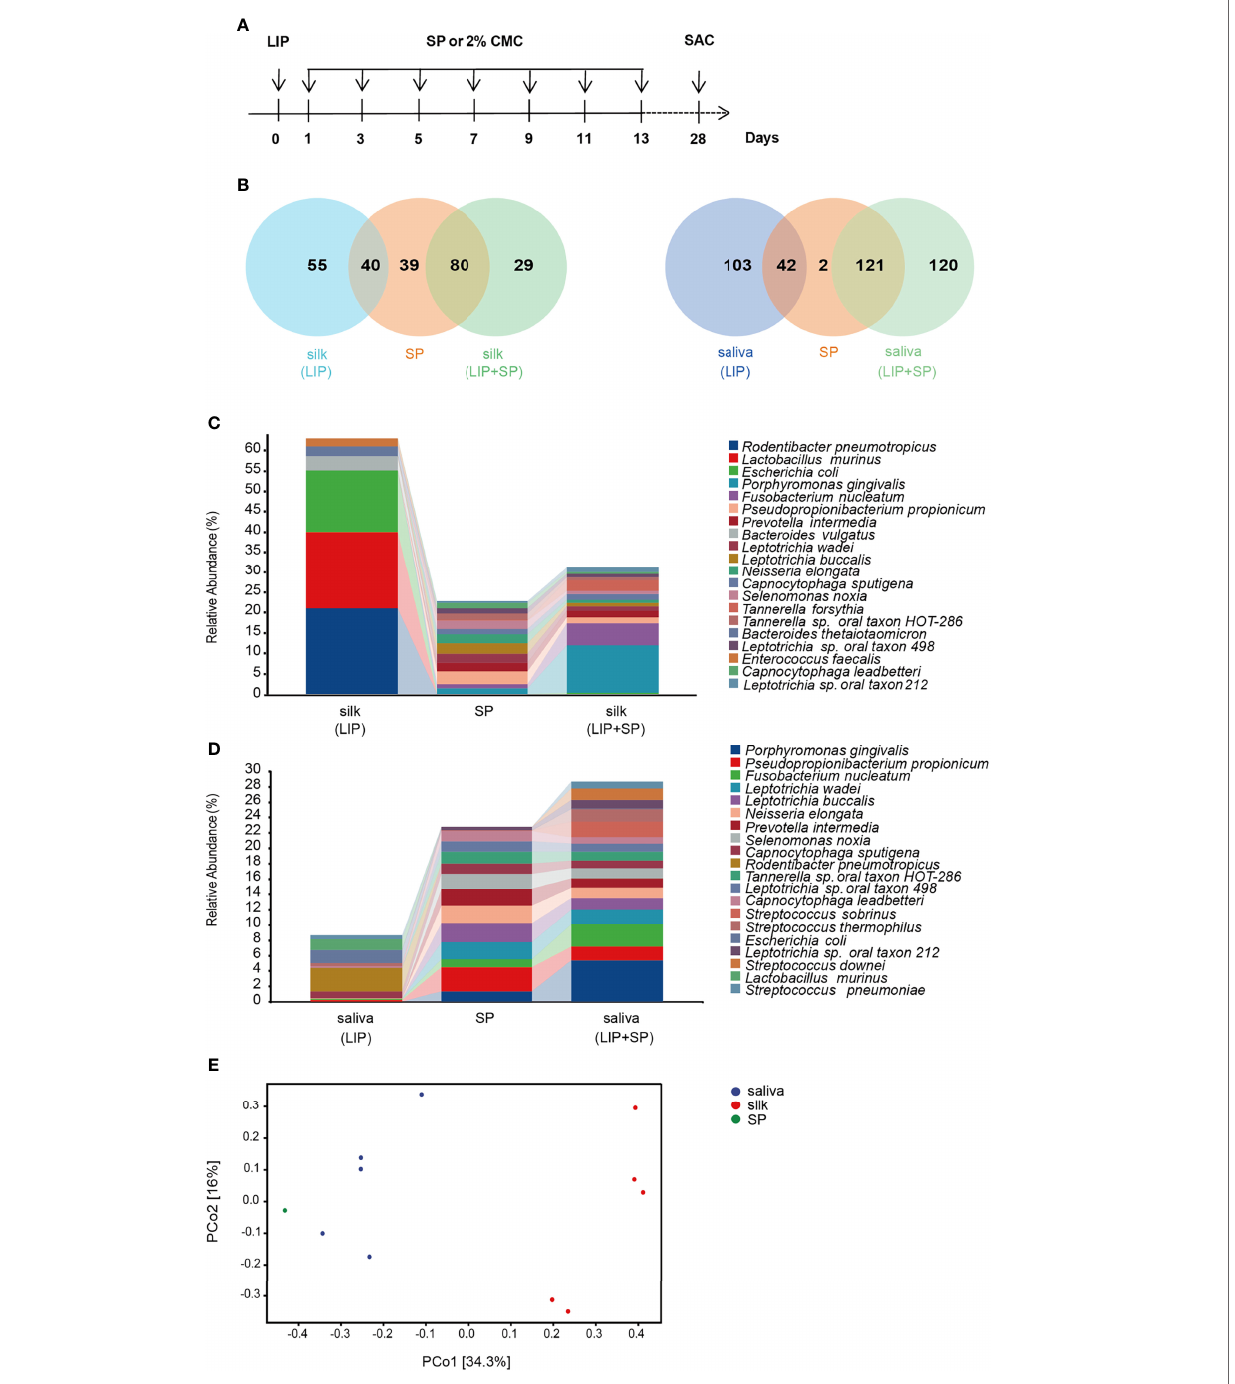
FIGURE 1 | Human periodontitis-causing bacteria ef fi ciently colonize in the mouse model. (A) Schematic illustration of experimental design. LIP, ligature- induced periodontitis. SP, subgingival plaques from patients with periodontitis. CMC, carboxymethylcellulose, and SAC, sacri fi ce. (B) The Venn diagrams showing the overlapped and different bacteria species between mouse silk ligature and human subgingival plaque (left), and between human subgingival plaque and mouse saliva (right). (C) Taxonomic composition of bacterial community at species level in mouse silk ligature and human subgingival plaque. (D) Taxonomic composition of bacterial community at species level in mouse saliva and human subgingival plaque. (E) b -diversity of SP and saliva, silk ligature bacteria at species level in LIP + SP group, assessed by principal coordinate analysis (PCoA) based on bray – curtis distance. (n =